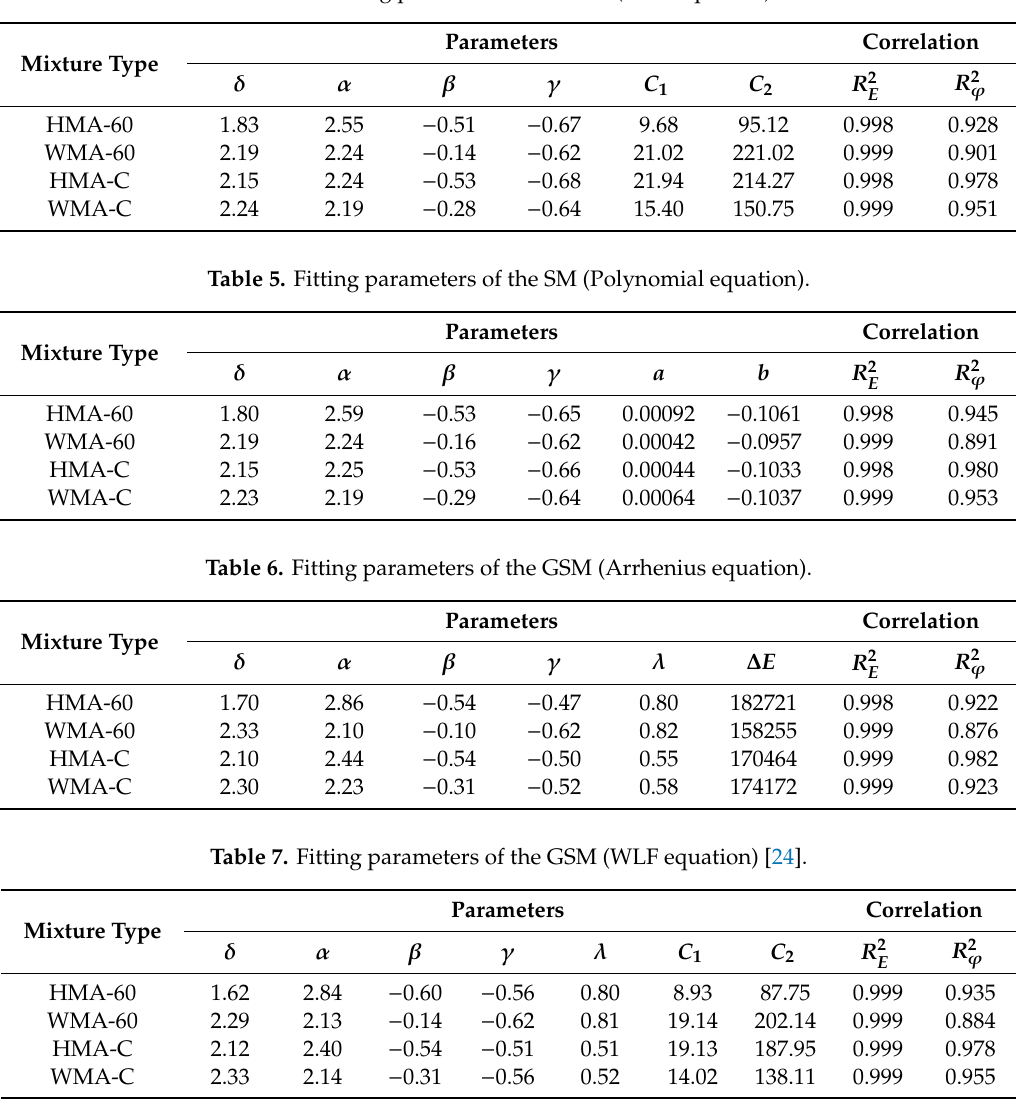
Table 4. Fitting parameters of the SM (WLF equation).